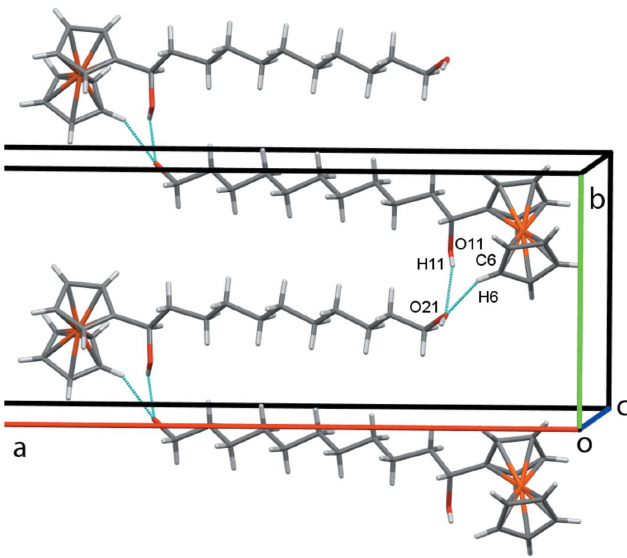
Figure 3 Chains of molecules of 1 propagating along b with O—H (cid:2)(cid:2)(cid:2) O and C— H (cid:2)(cid:2)(cid:2) O hydrogen bonds shown as blue lines.